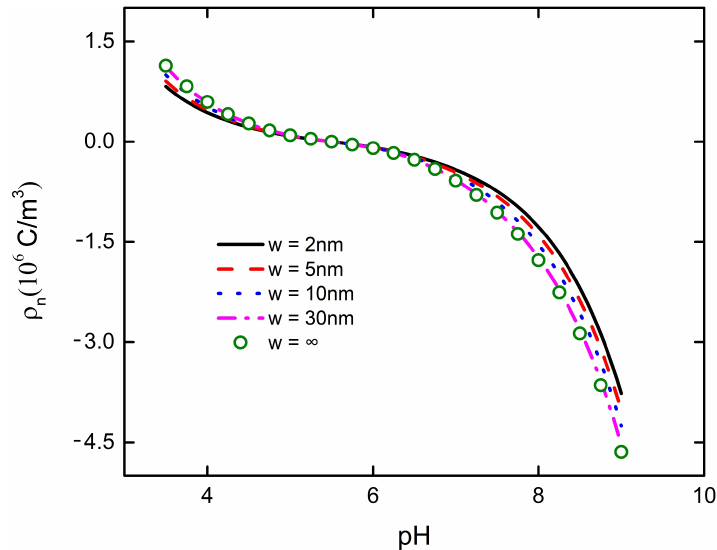
Figure 3. The change curve of bulk charge density of the polyelectrolyte (PE) brush layer at the bottom of the nanoparticle with pH under di ff erent spacing between particle and plate at C KCl = 1